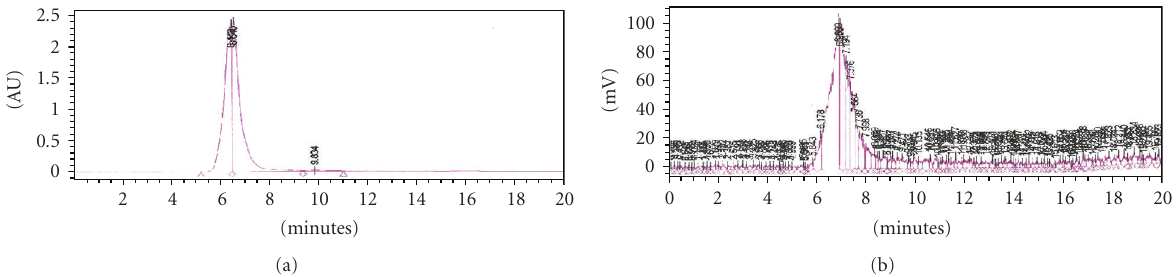
Figure 2: HPLC analysis of 99m Tc-N4-AMT at a flow rate of 0.5mL/min using a C-18 reverse column under UV absorbance of 274nm.